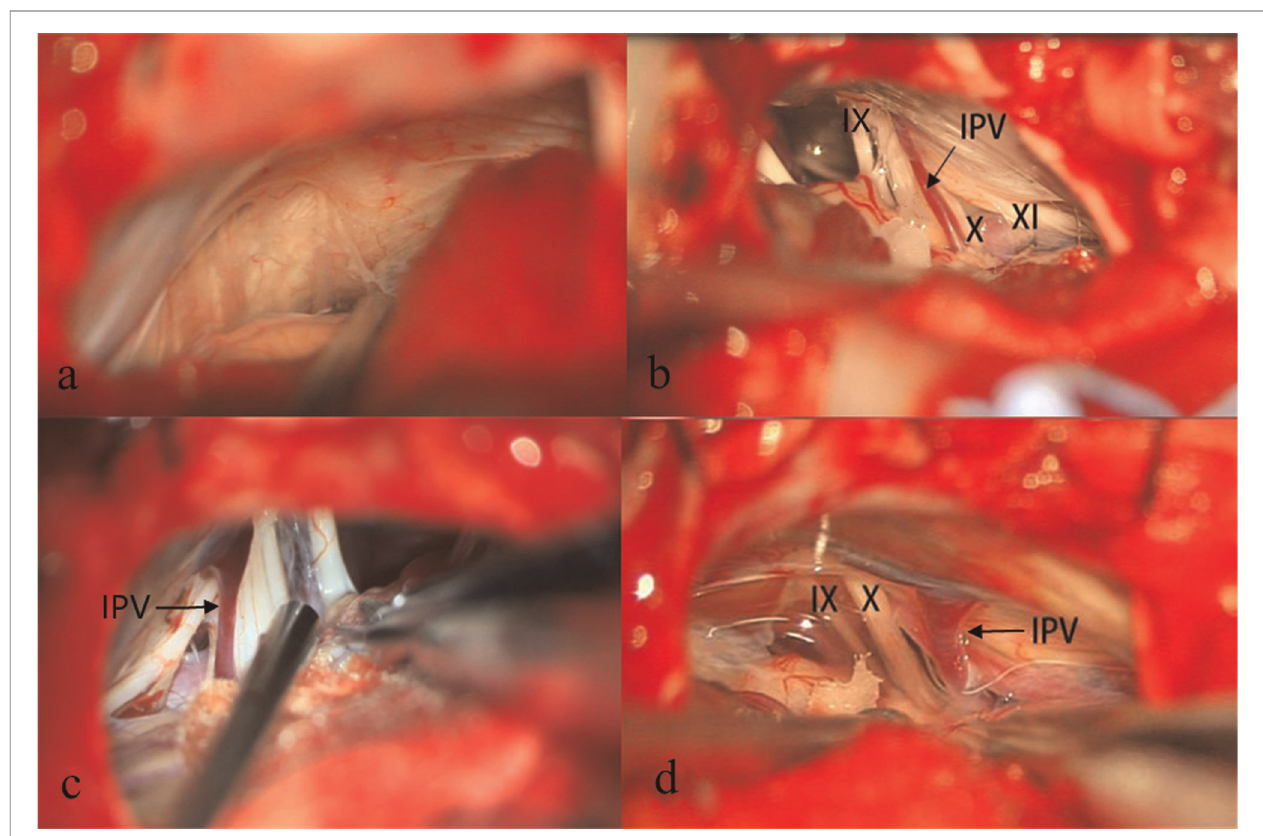
FIGURE 2 | Example of patient with no apparent IPV ( A ). Three types of IPVs were recorded during MVD based on diameter- the diameter <0.5 mm ( B ), 0.5 mm – 1 mm ( C ), >1 mm ( D ). IX, Glossopharyngeal Nerve; X, Vagus Nerve; XI, Accessory Nerve; IPV, Inferior Petrosal